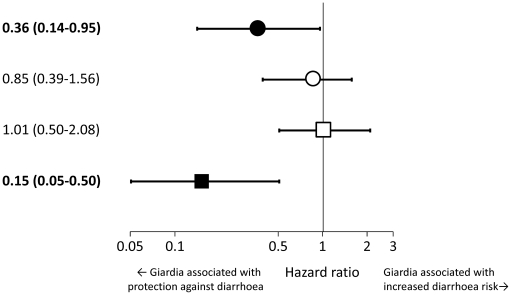
Association between Giardia and diarrhea rates, stratified by intervention.Estimates indicate crude incidence rate ratios (of first or only episodes with ≥3 watery stools/24 h), with 95% confidence intervals. An incidence rate ratio (IRR) of 1 (vertical line) indicates that Giardia intestinalis at baseline was not associated with diarrhea rates. An IRR of less than 1 indicates that Giardia intestinalis at baseline was associated with a reduction in diarrhea rates. Black dot: IRR in children receiving zinc. White dot: IRR in children receiving multi-nutrients without zinc. White square: IRR in children receiving multi-nutrients. Black square: IRR in children receiving placebo. Giardia was associated with protection against diarrhea among children receiving zinc or placebo, but not among children receiving multi-nutrients.